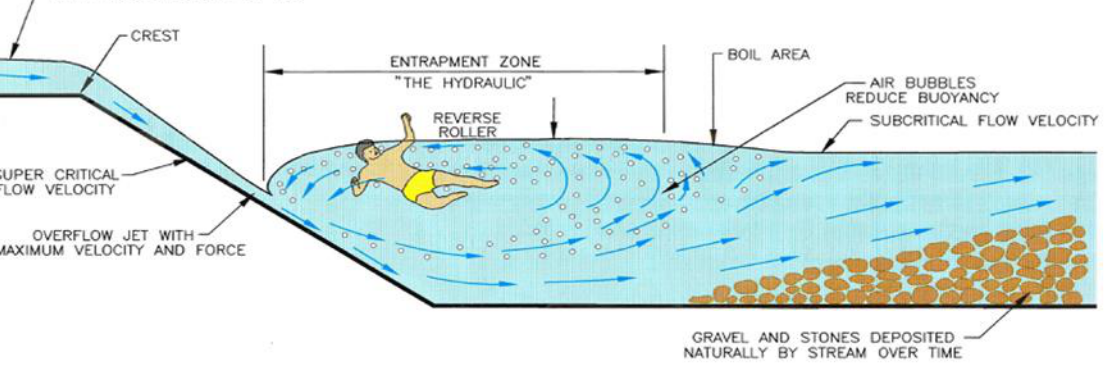
Figure 2. Graphical description of a low-head dam with a submerged hydraulic jump. This graphic was created by Wright Water Engineers and was presented at Dam Safety 1995, the 12th annual conference of the Association of State Dam Safety Officials in Atlanta, GA, September.